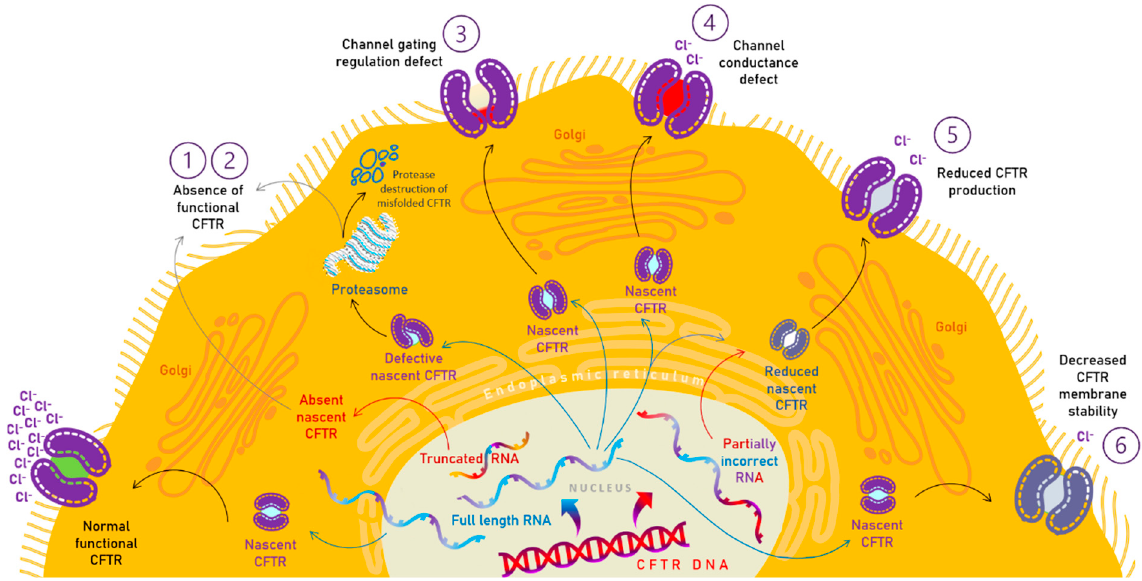
Figure 2. The six mutation classes of cystic fibrosis transmembrane conductance regulator (CFTR) gene. The defective mechanisms (1–6) are presented in comparison with the physiologic process encountered in healthy subjects. [6–8].